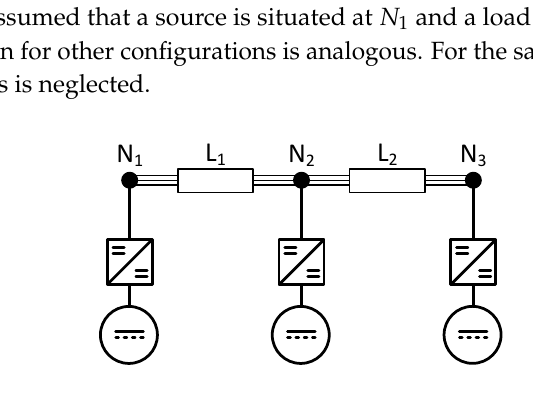
Figure 5. Example of a DC distribution grid with three nodes and two lines in a bus